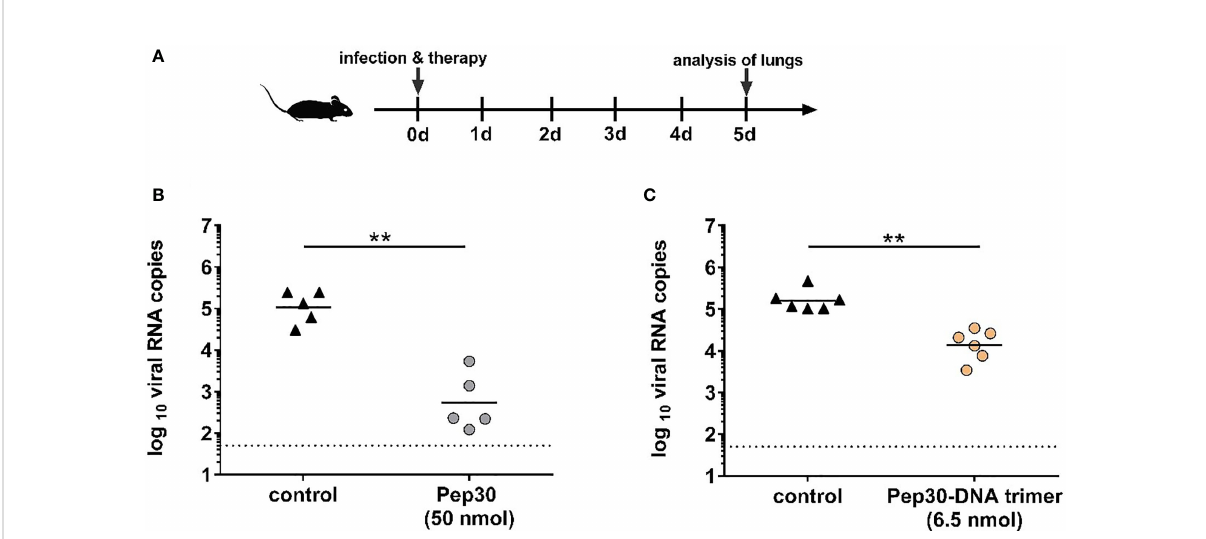
FIGURE 6 Antiviral activity of peptide candidate Pep30 and trimeric peptide-DNA construct in mice. In vivo experiments were performed according to the scheme shown in (A) . Brie fl y, BALB/c mice (n=5-6) were treated intranasally with 50 nmol (100 µg) of Pep30 (B) or 6.5 nmol of Pep30-DNA trimer (C) mixed together with 10 4 FFU of puri fi ed RSV. Compound-virus mixtures were applied immediately after mixing into the nose of mice in 50 µl total volume. The control group received 10 4 FFU of puri fi ed RSV in 50 µl vehicle (DMSO in PBS). On day fi ve post-infection, mice lungs were collected, homogenized, and subjected to viral RNA load analysis by RT-qPCR. Viral loads are shown for each individual mouse in addition to the geometric means of each group. Dotted line represents the lower limit of detection = 50 viral RNA copies. Statistical analysis was done using Mann-Whitney-U-test ( ∗∗ = p <